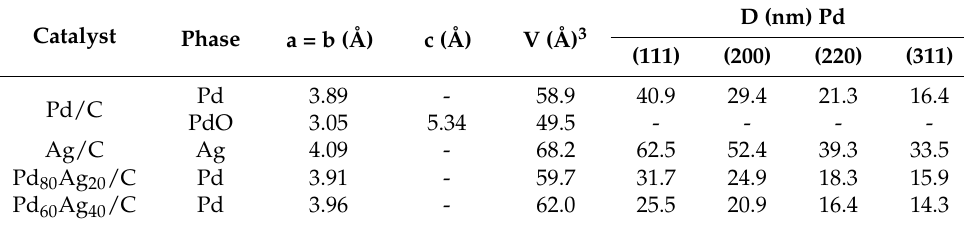
Table 2. Characteristic crystallographic parameter of each electrocatalyst defined from XRD analyses.